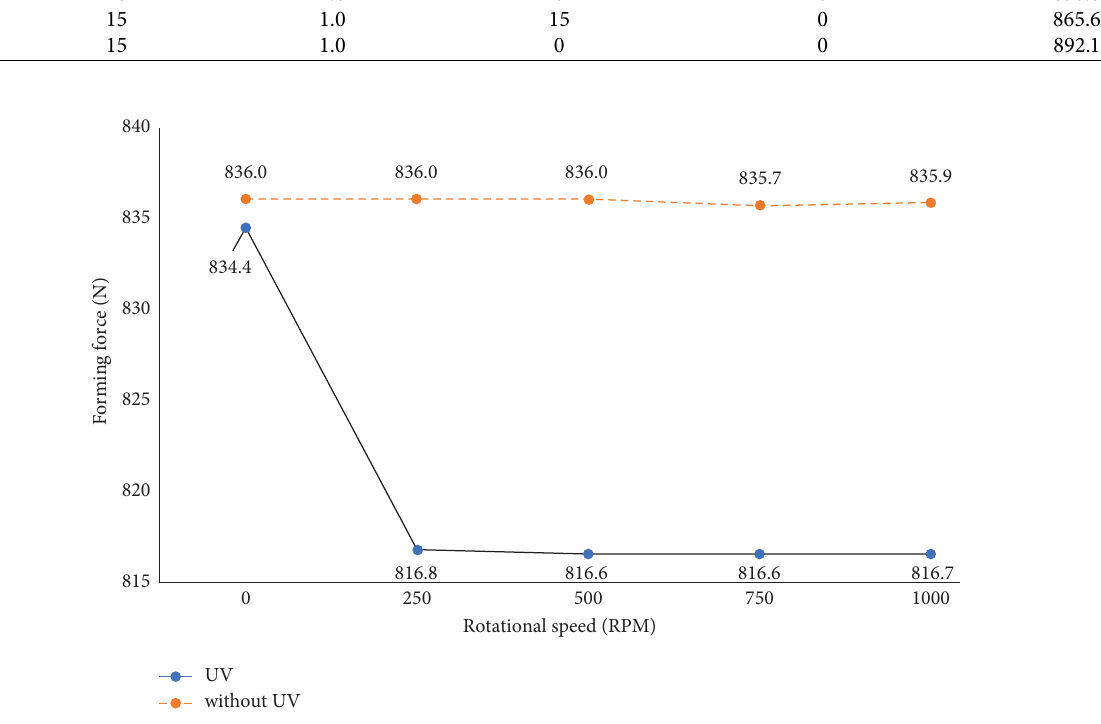
Figure 12: Forming force with diferent rotational speeds. Table 4: Simulation setup and results with diferent rotational